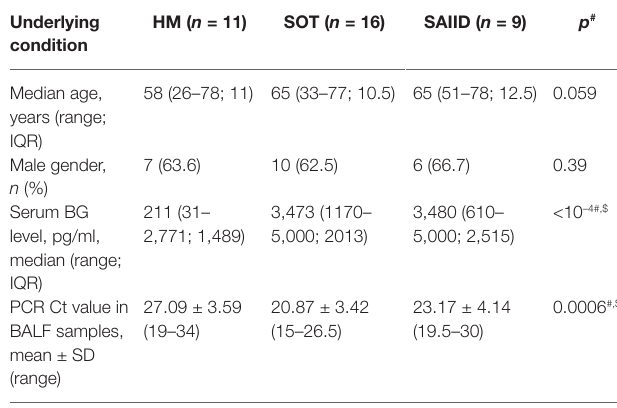
TABLE 3 | Statistical analyses of categorical and numerical variables in patients with Pneumocystis pneumonia and patients colonized by Pneumocystis . Clinical